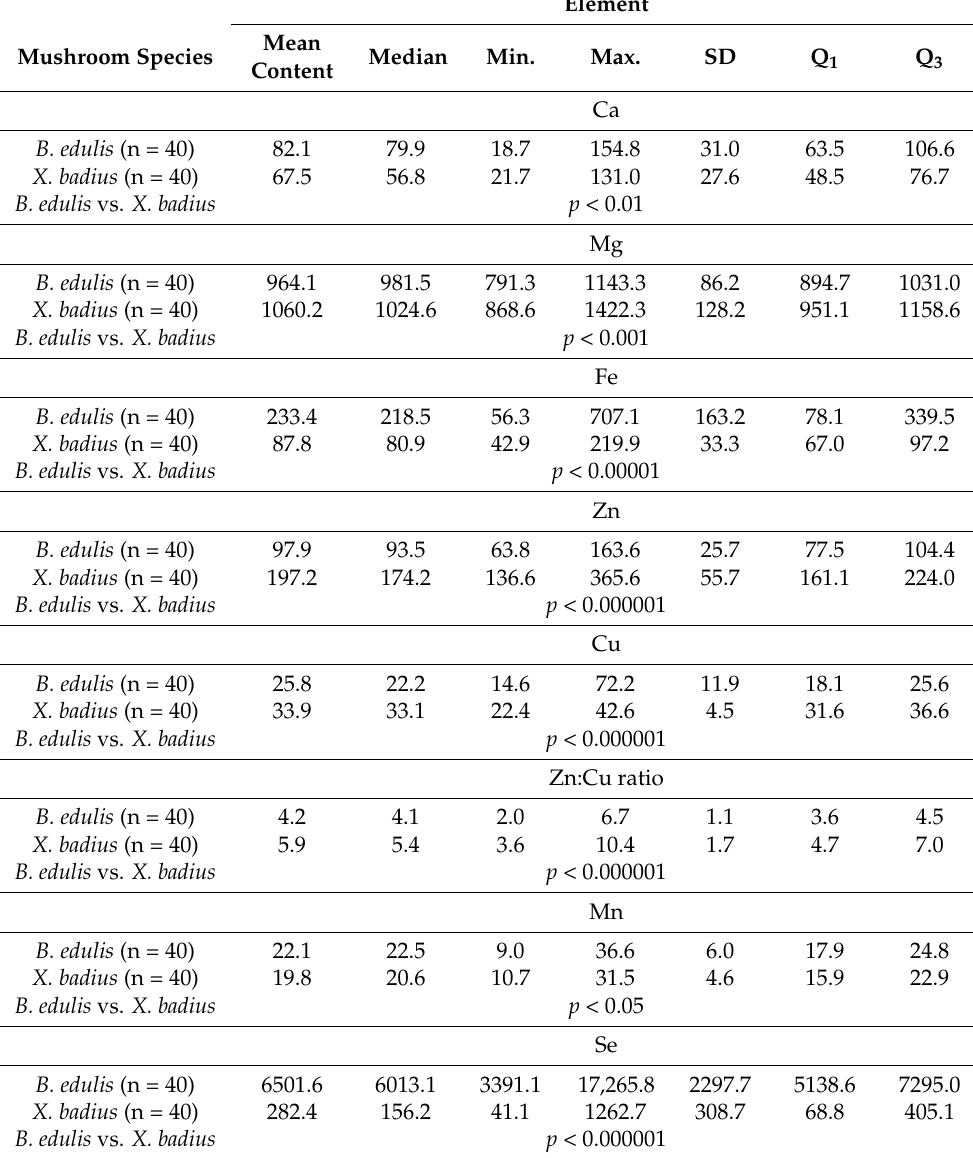
Table 4. Concentrations of Ca, Mg, Fe, Zn, Cu, Mn (mg/kg), and Se ( µ g/kg) in dried